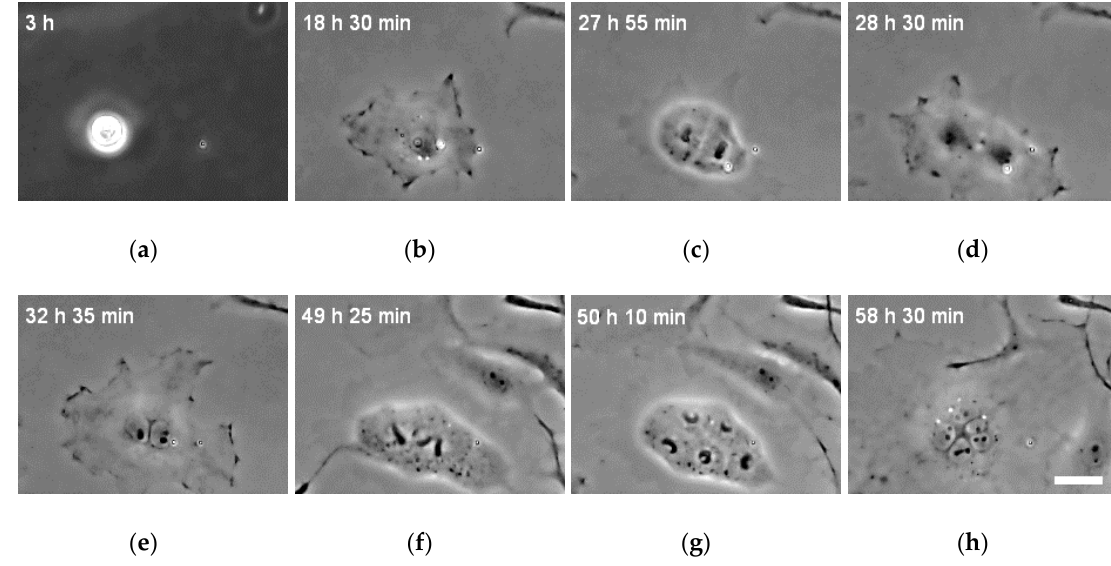
Figure 4. Typical time-lapse images of the XTC-YF cells incubated in medium containing 100 µM Y-27632 and seeded on a less hydrophilic glass bottom dish. Bars in (h) = 30 µm and are applicable to all images. The numbers in the upper left of the panels indicate the time after seeding.